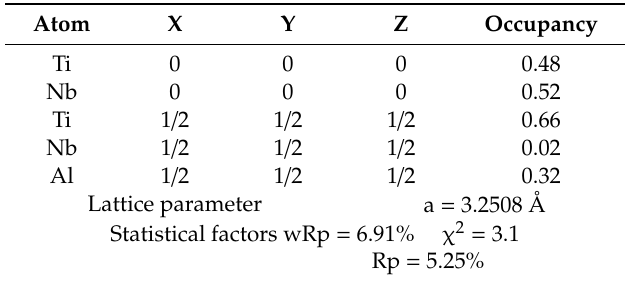
Table 1. Summary of the NPD Rietveld refinement results.